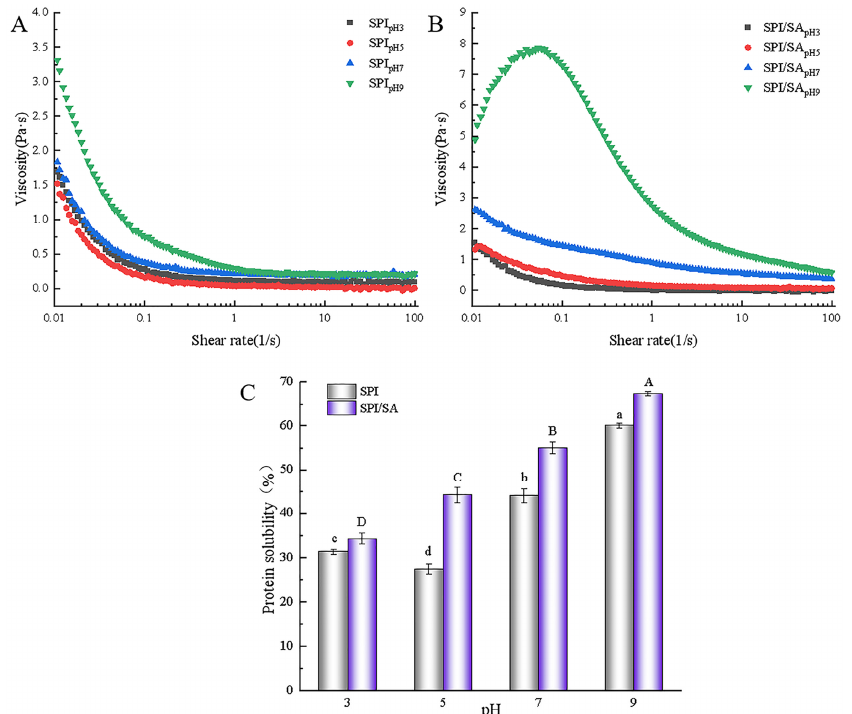
Figure 5. Apparent viscosity ( A , B ) and protein solubility ( C ) of SPI and SPI/SA microparticles at different pH values. Different lowercase letters (a–d) within a column for each SPI microparticles are significantly different ( p < 0.05). Different capital letters (A–D) within a column for each SPI/SA microparticles are significantly different ( p <